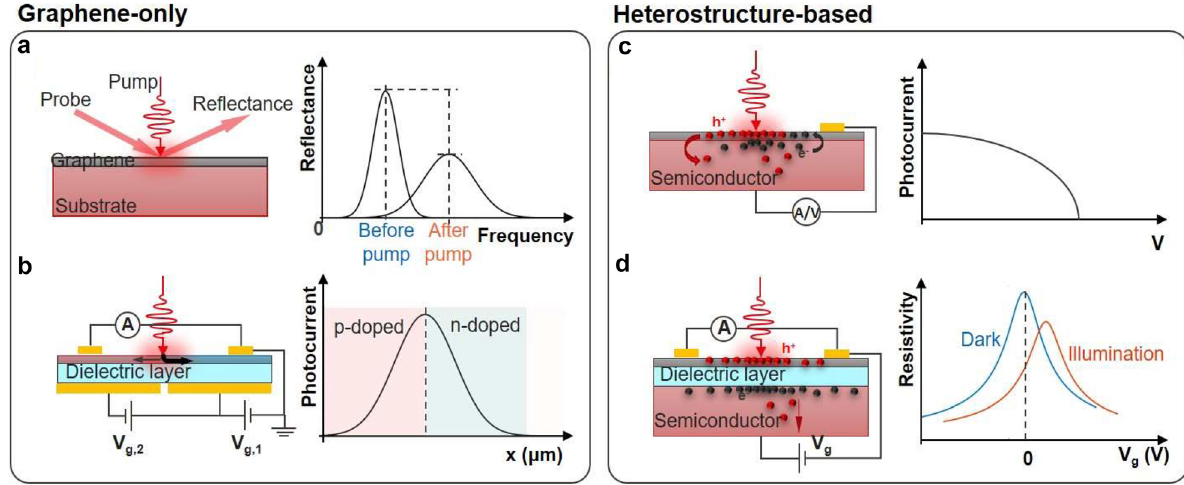
Figure 3: Overview of photo-modulation